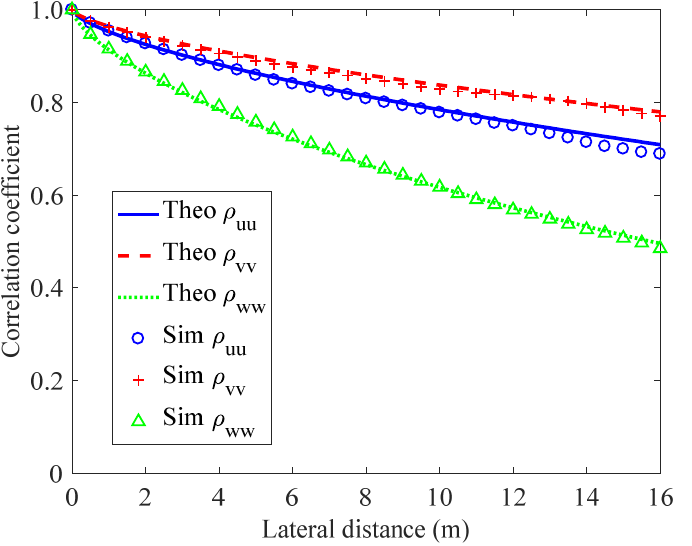
Figure 6. Comparison between simulated and theoretical correlation coefficients along lateral direc- tion for flight over a city center.